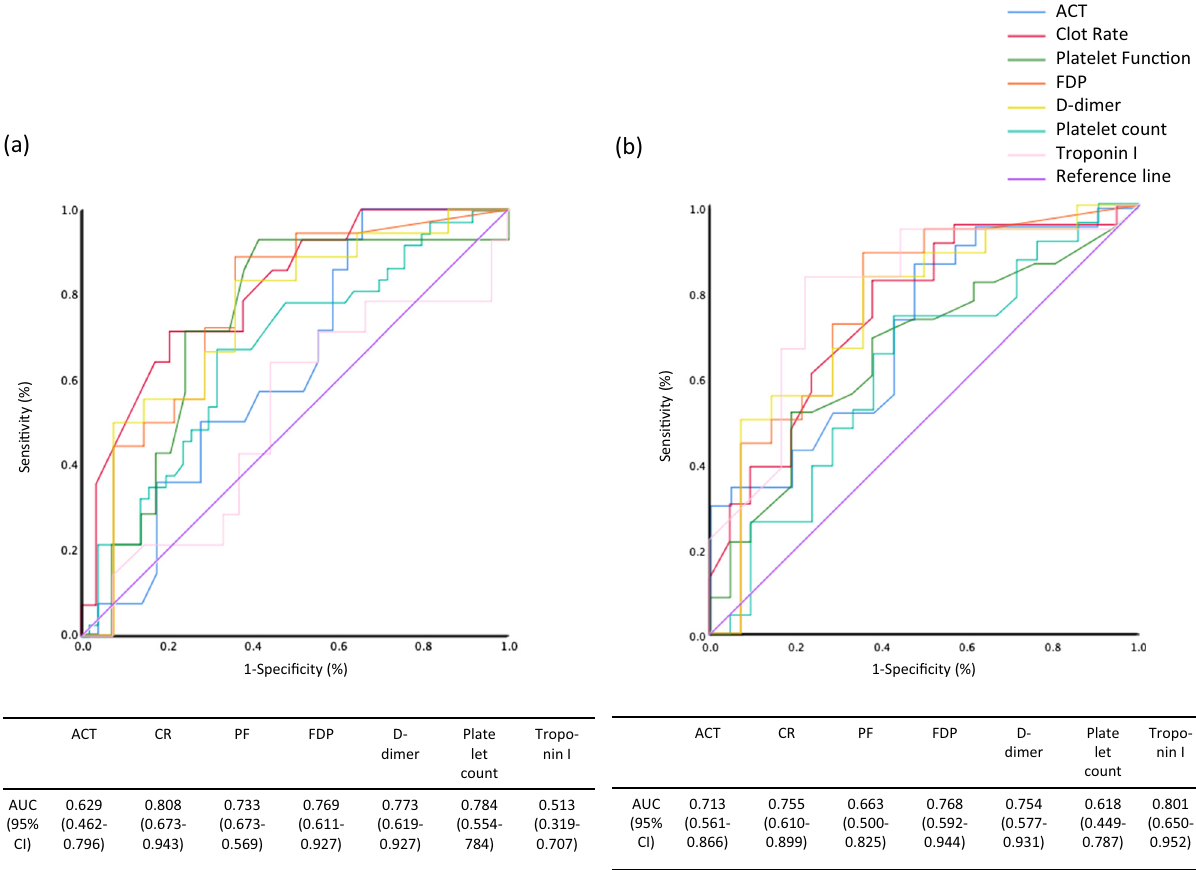
Speci fi city ( % ) 44.0